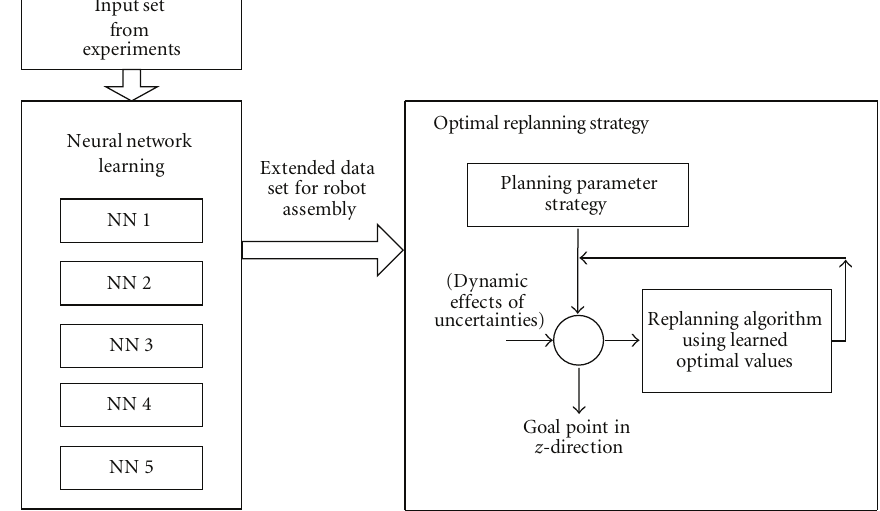
Figure 5: Optimal replanning strategy based on neural learning.